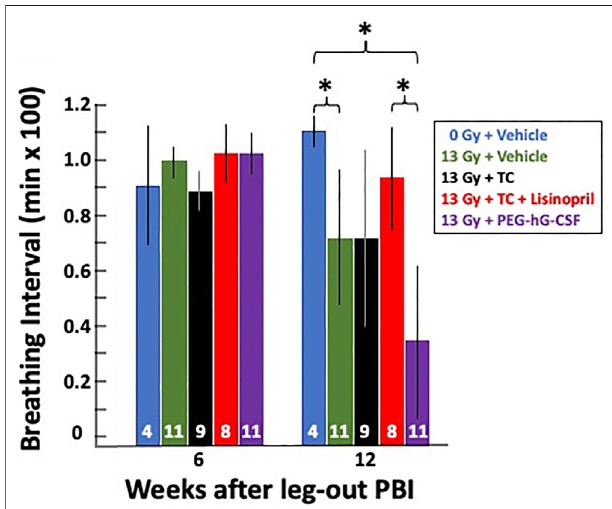
FIGURE 5 | Radiation pneumonitis is mitigated by lisinopril after 13 Gy leg-out PBI. Graphical representation of breathing intervals as a secondary and functional endpoint for lung injury were obtained from all 13 Gy leg-out PBI irradiated treatment groups and non-irradiated controls. Breathing rates were recorded biweekly from weeks 4 to 16 post-irradiation and converted to breathing intervals (see Methods ). The bars represent means with 95% CIs. Rats moribund with lung injury con fi rmed at necropsy (13 Gy + vehicle n (cid:2) 2, 13 Gy + PEG-hG-CSF n (cid:2) 6, 13 Gy + TC n (cid:2) 2) were given a breathingintervalof0at12 weekstoaccountforattrition.Numbersinthebars represent N in each group. Asterisks represent p < 0.05 between treatment groups at 12 weeks, in brackets: 0 Gy + vehicle vs. 13 Gy + PEG-hG-CSF, 0 Gy vehicle vs. 13 Gy + vehicle, 13 Gy + TC + lisinopril vs. 13 Gy + PEG-